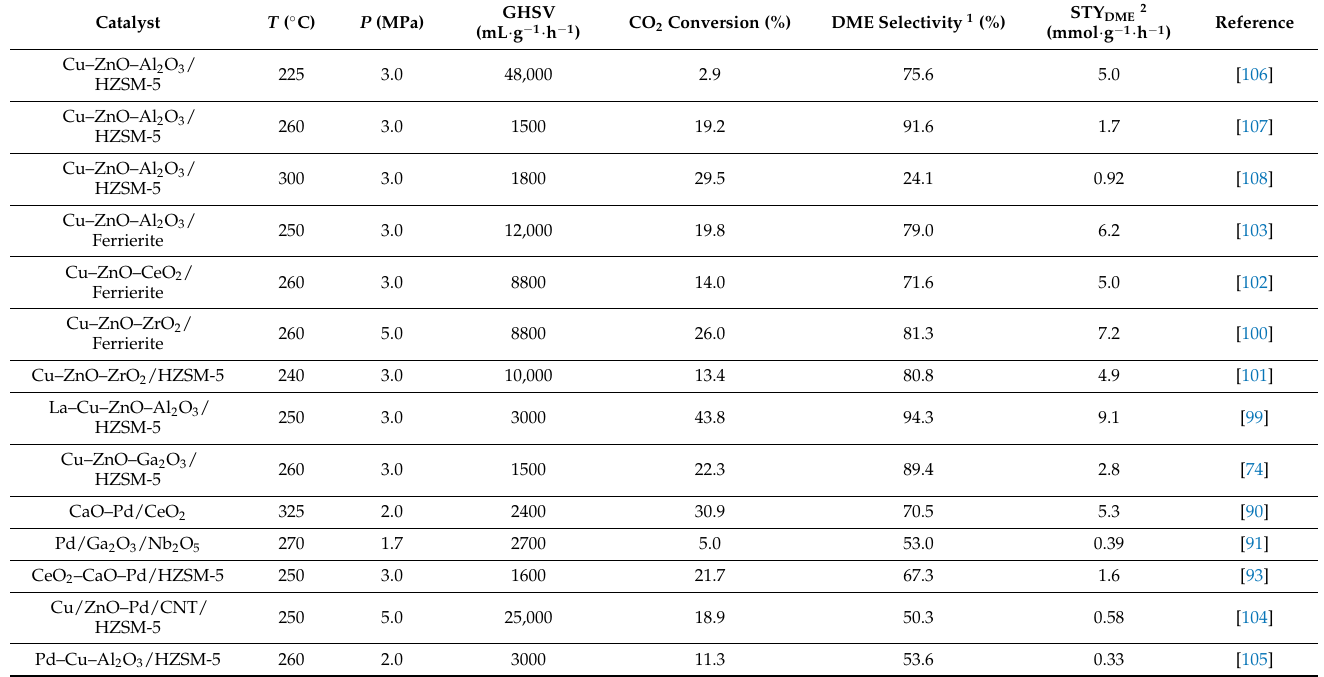
Table 2. Catalytic performance of Cu- and Pd-based catalysts in the CO 2 hydrogenation to dimethyl ether (DME).